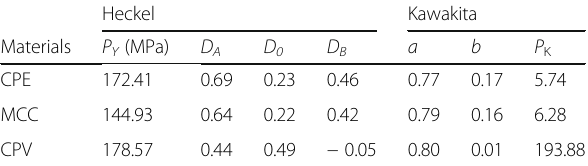
Table 2 Heckel and Kawakita parameters for MCC, CPE, and CPV Heckel